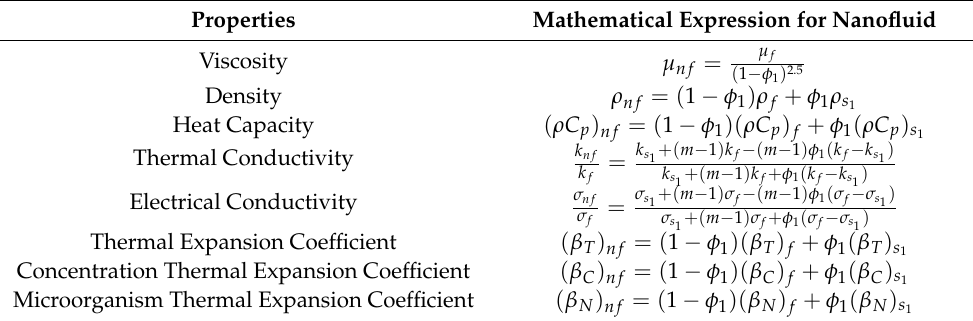
Table 2. Thermophysical features of nanofluid ([29,54]).